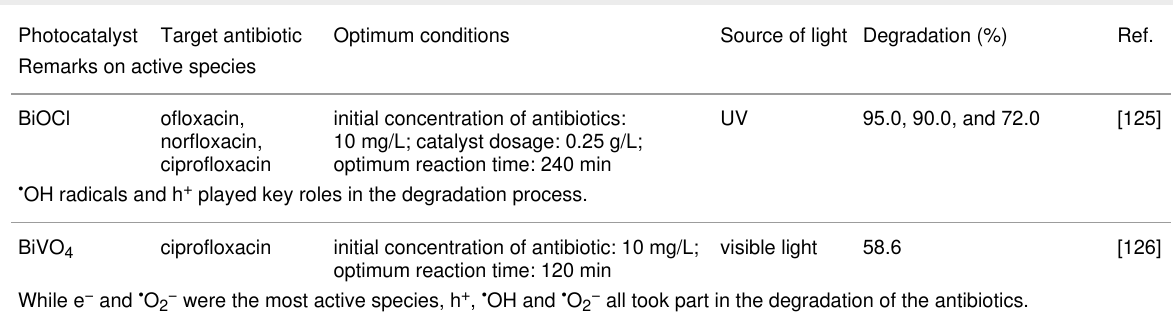
Table 4: Undoped Bi-based nanostructured photocatalysts for antibiotic